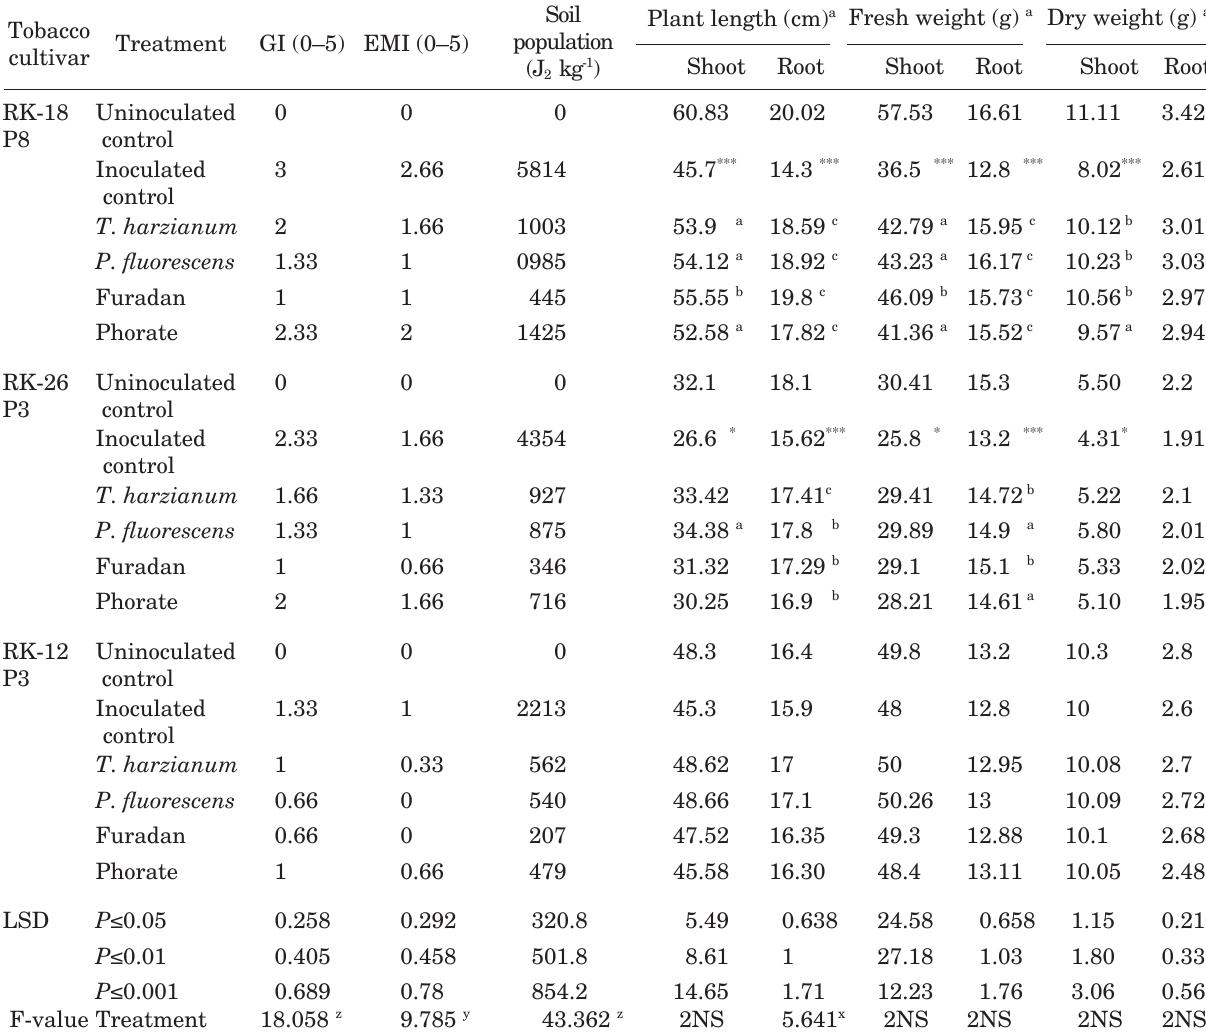
kg -1 soil). Each value is the mean of three 2